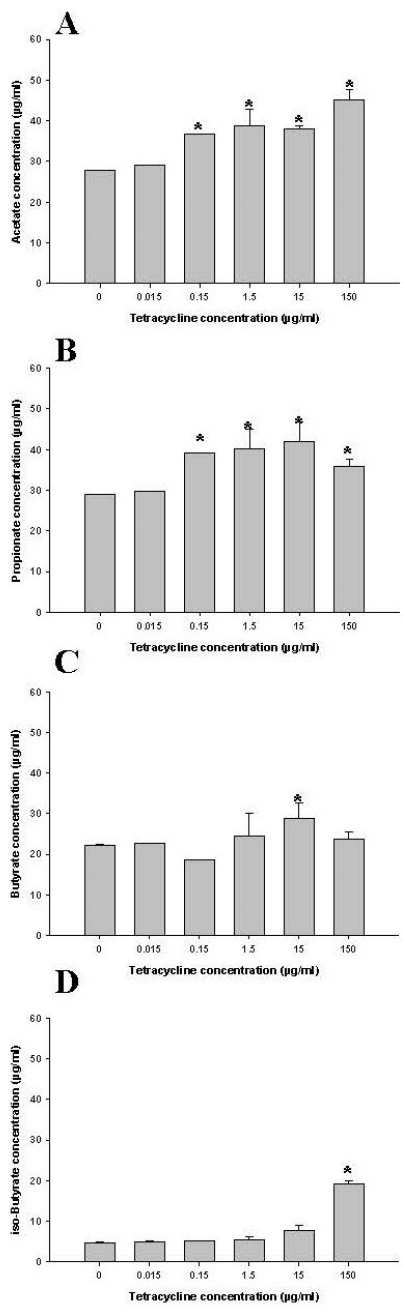
Figure 6. Comparison of acetate ( A ), propionate ( B ), butyrate ( C ), and isobutyrate ( D ) in controls (no treatment) and tetracycline-treated samples after 7 days. * indicates statistically significant dif- ferences from control ( p <